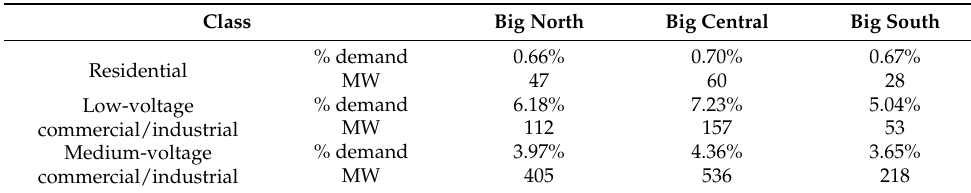
Table 4. Adoption of distributed generation in the current regulation scenario by class and region in